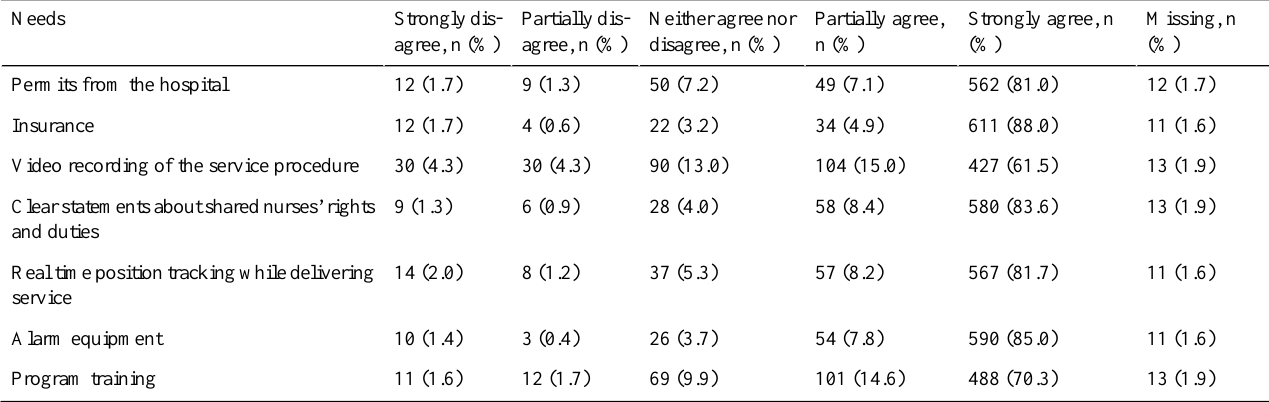
Missing, n (%)Strongly agree, n (%)Partially agree,